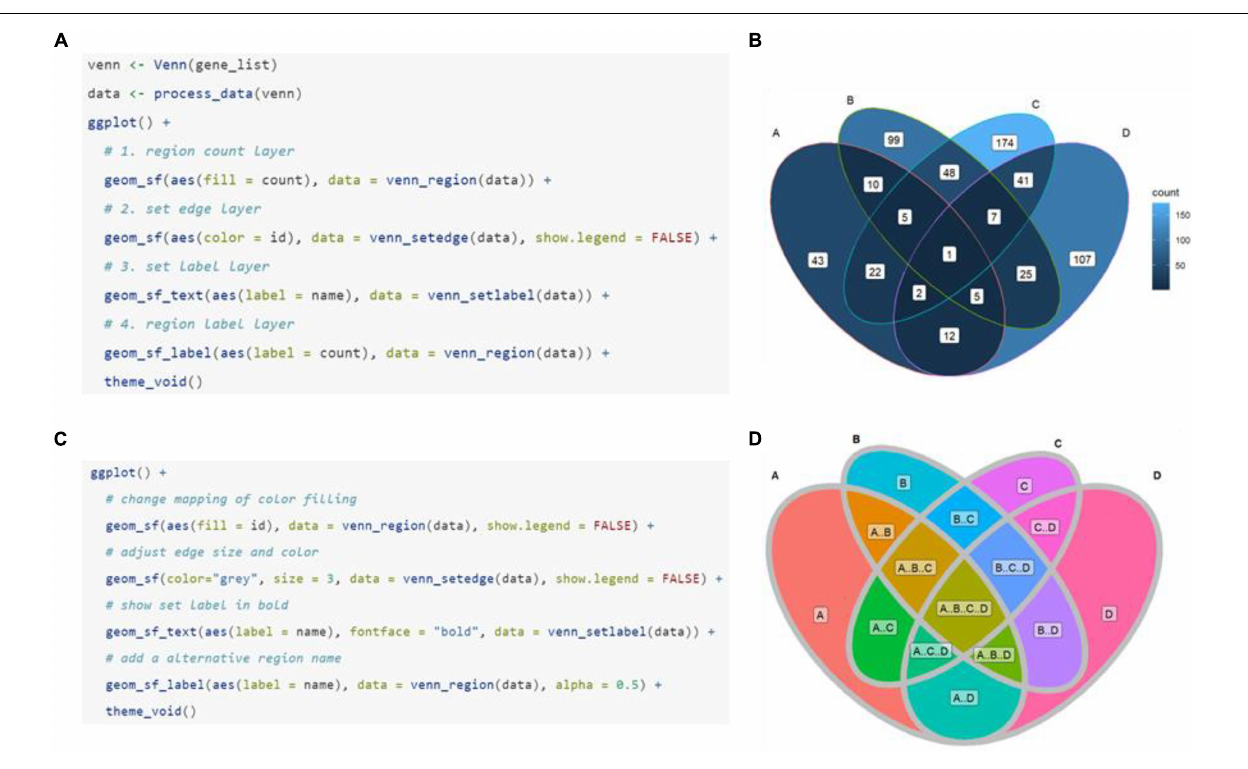
the region fill color, line color/thickness, text style, and so on ( Figures 2C,D